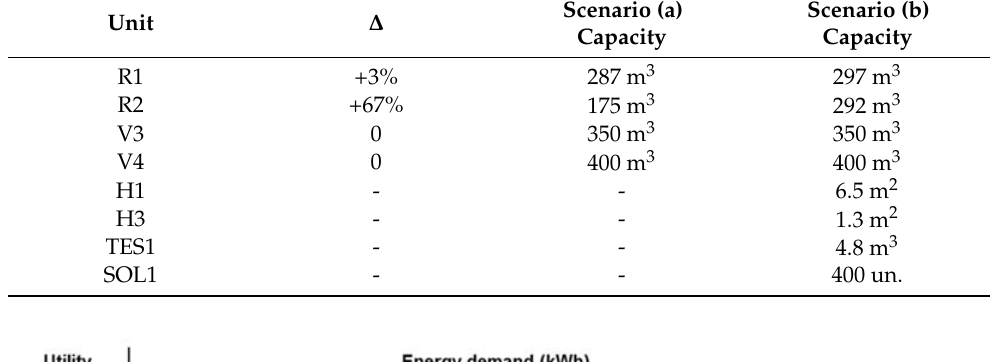
Figure 4. Optimal scheduling and batch processing solutions for scenarios ( a , b ). Table 4. Optimal unit design solutions.